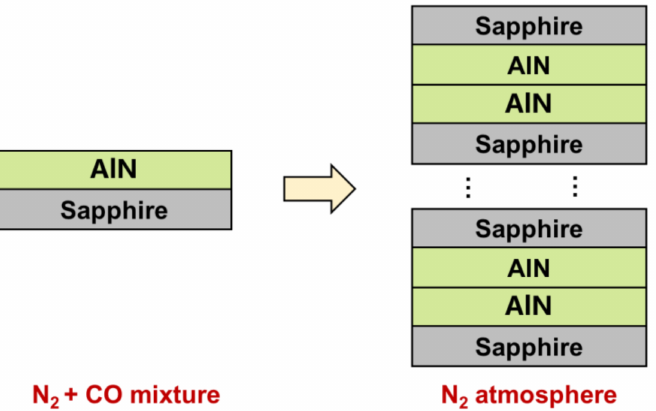
Figure 14. The evolution of HTA framework: the annealing atmosphere changes from the initial N 2 + CO mixture to the present pure N 2 , and the placement way changes from one wafer to multiple face-to-face